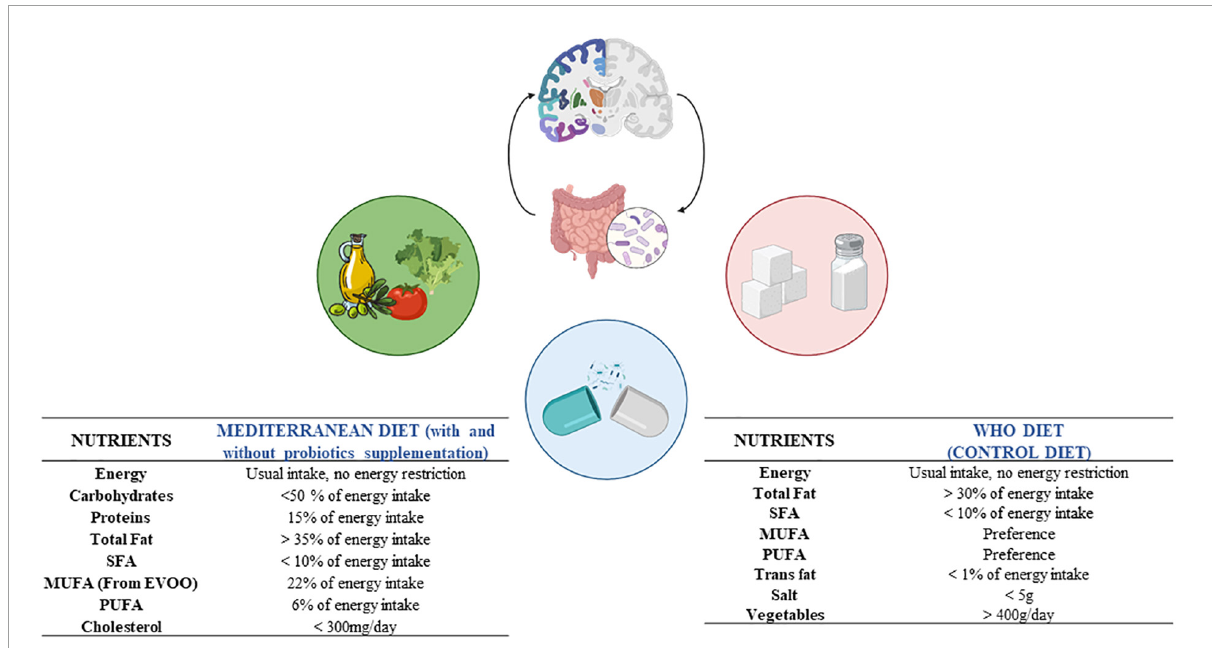
FIGURE3 Nutrient composition of the dietary interventions analyzed in the study. WHO, world health organization; SFA, saturated fatty acids; MUFA, monounsaturated fatty acids; PUFA, polyunsaturated fatty